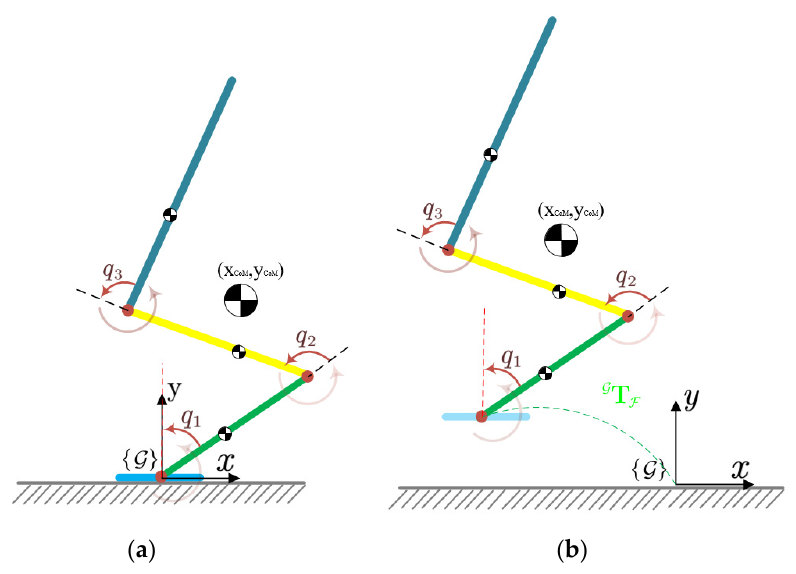
Figure 4. Dynamic model ( a ) in the stance phase and ( b ) in the flight